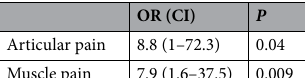
Table 5. Risk factors for development of persistence of symptoms at